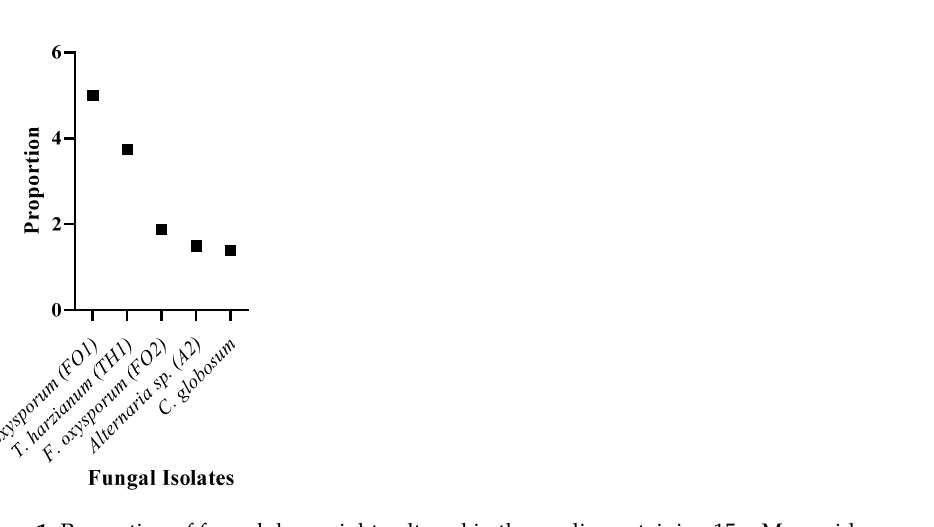
Figure 1. Proportion of fungal dry weight cultured in the media containing 15 mM cyanide.